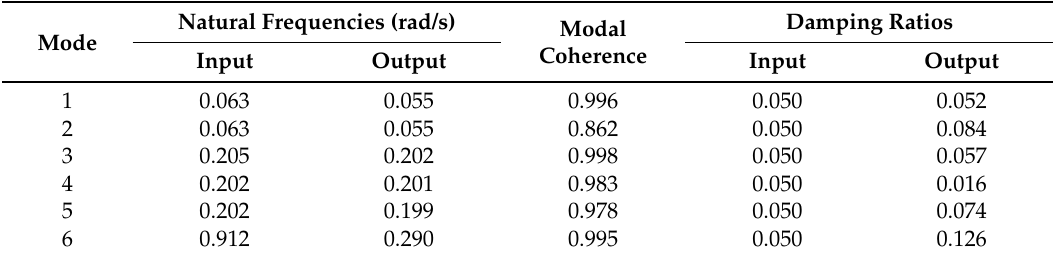
Table 7. Evaluation of FDD efficiency for the second case.